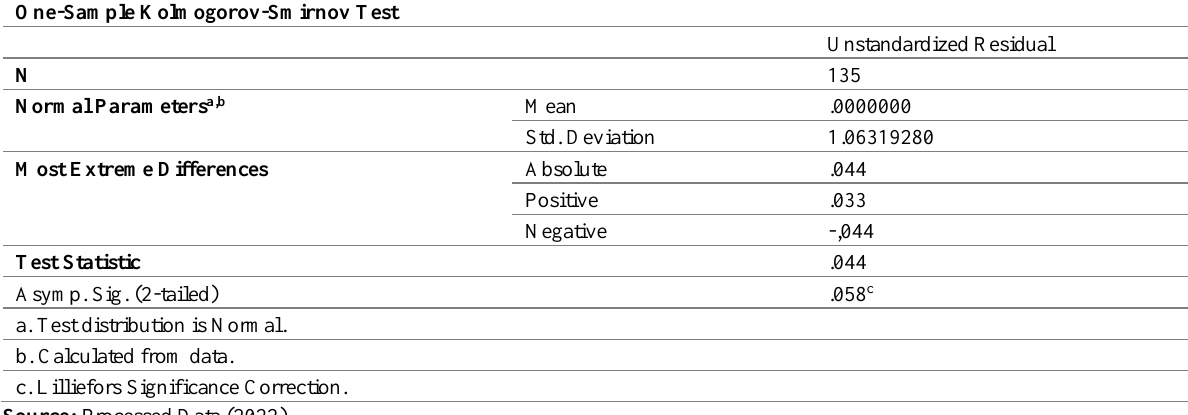
Table 2: Results of Normality